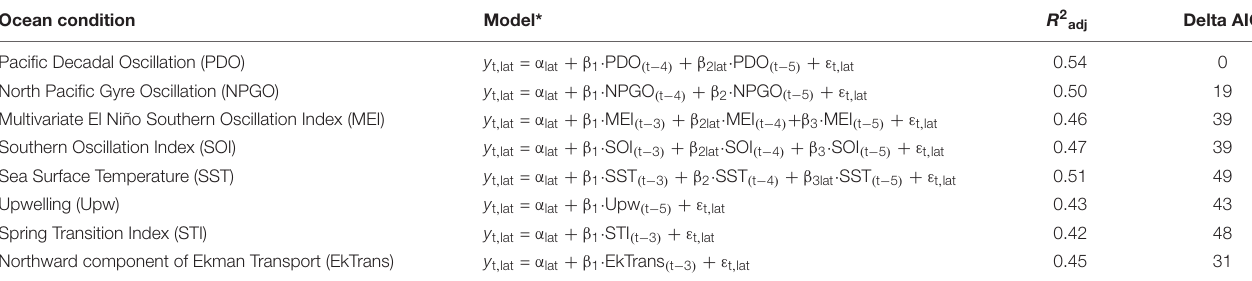
TABLE 3 | Selected models of individual ocean conditions lagged 3, 4, or 5 years and Dungeness crab commercial catch per unit effort ln(CPUE) along the U.S. west coast, including the adjusted R 2 and delta Akaike information criterion (AIC) for each model. Ocean condition